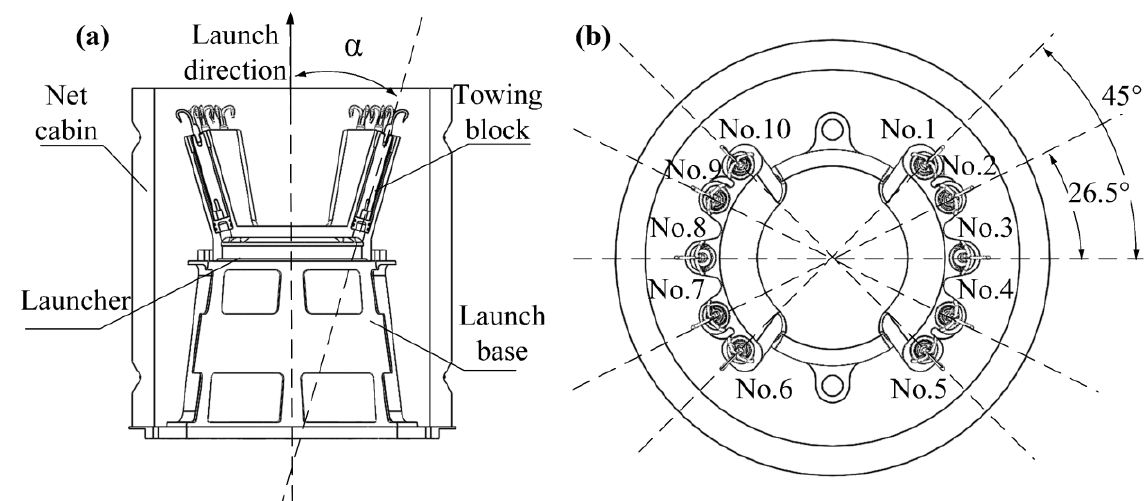
Figure 2. Main structure of rectangular tether-net system. ( a ) Cutaway view. ( b ) Top view.